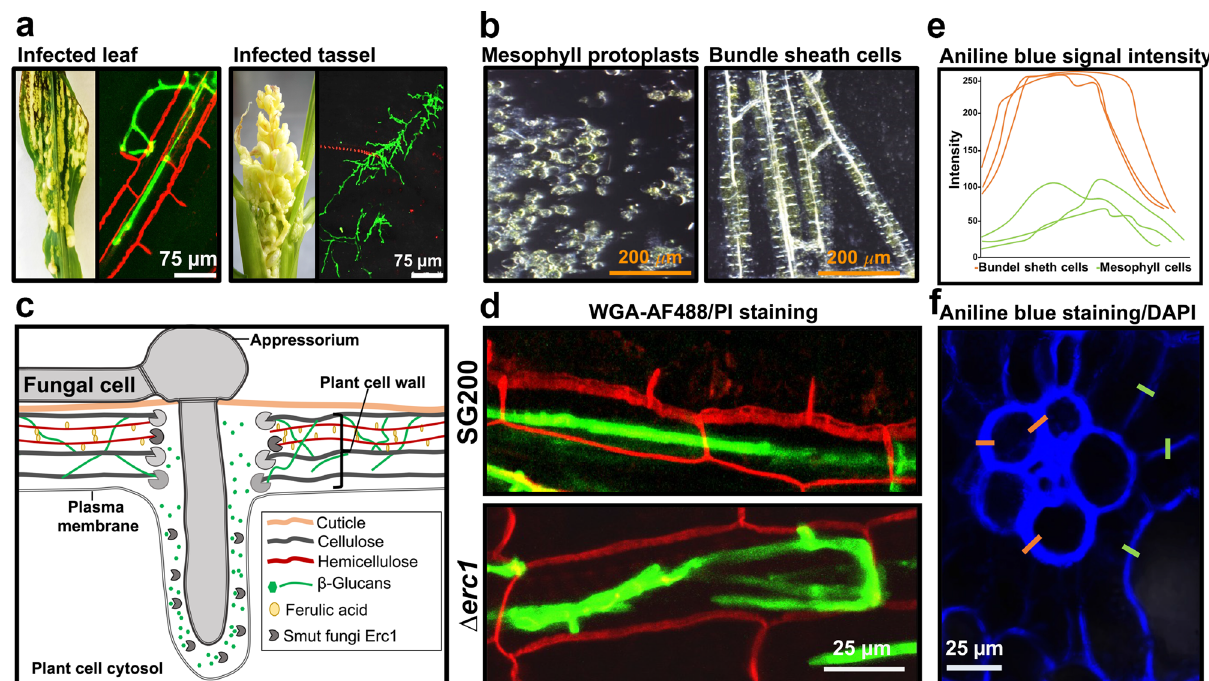
Fig. 6 | Cell type-speci fi c function of Erc1. a Microscopic observation of trapped Ustilago maydis infected maize leaf and tassel tissues via WGA-AF488/Propidium iodide staining. WGA-AF488 (green color indicates fungal cell wall): excitation at 488nm and detection at 500-540nm. PI (red color indicates bundle sheath cells): excitation at 561nm and detection at 580 – 630nm. Unlike leaf tissue, no bundle sheaths cells are detectable in tassel tissue. b Protoplastation of maize leaf cells. Pictures were taken after treatment with plant cell wall degrading enzymes. While the used enzyme mix has the ability to convert mesophyll cells into protoplasts, bundlesheathcellsremainintact. c Schematicdepictionofthebiotrophicinterface ofhost-smutinteraction.Fungus-derivedproteinsaredepictedingray.Duringhost